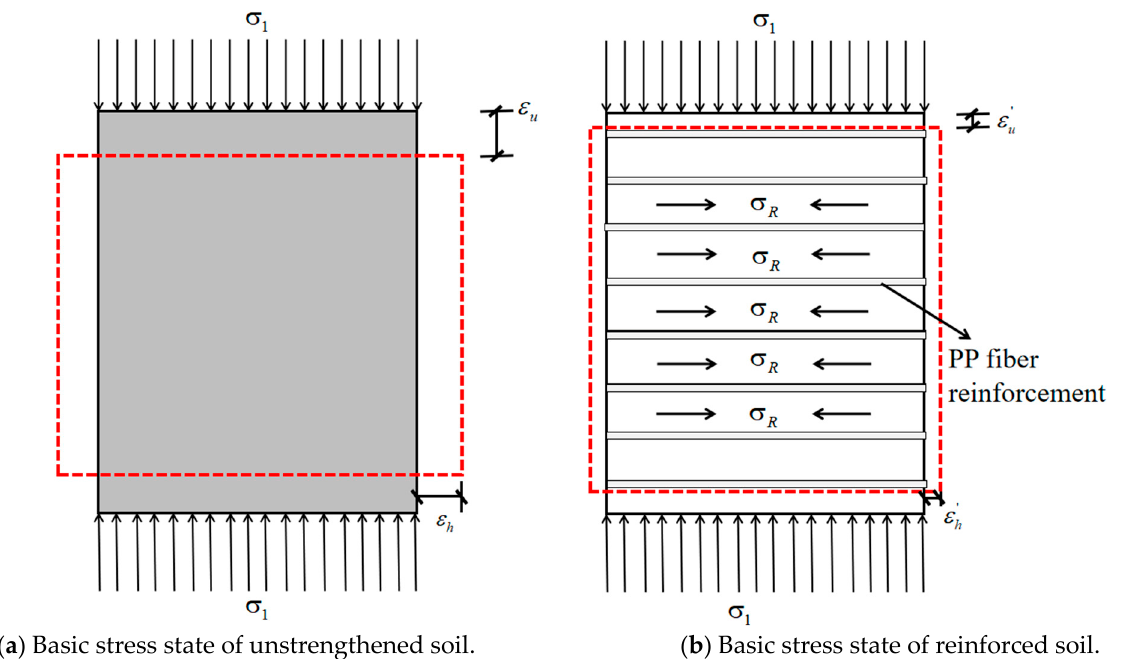
Figure 16. Basic stress state of cement–soil before and after reinforcement.